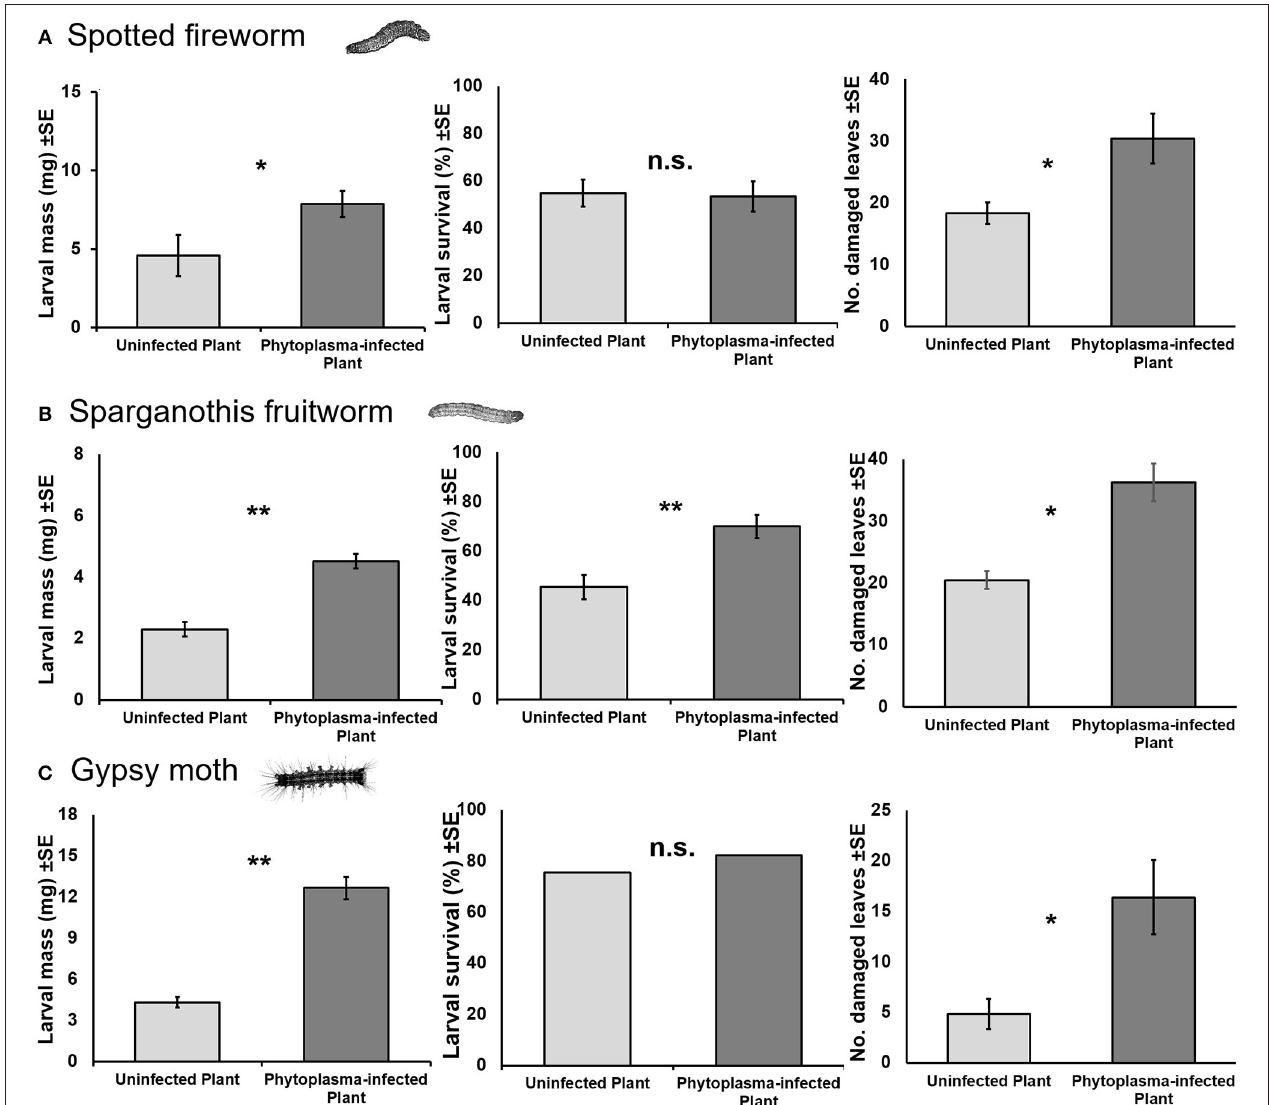
FIGURE 2 | Mean ( ± SE) larval mass and survival of spotted fireworm ( Choristoneura parallela ) (A) , Sparganothis fruitworm ( Sparganothis sulfureana ) (B) , and gypsy moth ( Lymantria dispar ) (C) , and number of damaged leaves, when fed on uninfected and phytoplasma-infected cranberry plants after 7 or 14 days. Asterisks indicate statistically significant differences (* p ≤ 0.05, ** p ≤ 0.001). n.s., not significant ( p > 0.05). N = 25, 30, and 35 for spotted fireworm, Sparganothis fruitworm, and gypsy moth,